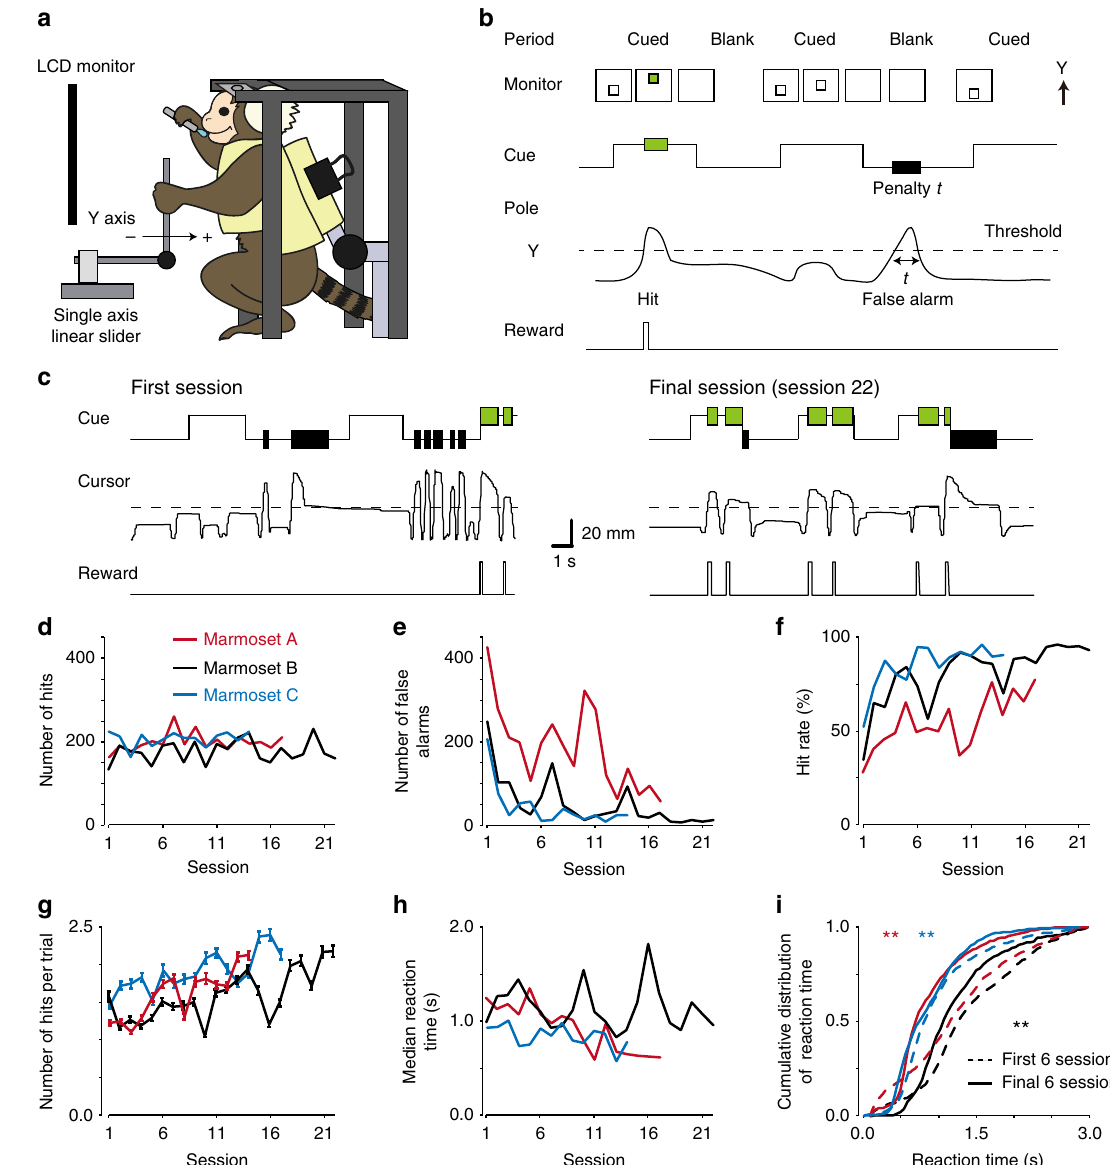
Fig. 2 Learning of visually cued pole-pull task. a Scheme of the task apparatus and head- fi xed marmoset. b Schematic diagram of the task. c Example of pole trajectories from marmoset B. d – g Time course of the hit number ( d ), the false alarm number ( e ), the hit rate ( f ), and the hit number per trial ( g ) across sessions. In g , only trials with at least one hit event were analyzed ( n = 73 – 183 trials for each session). Error bars indicate SEM. Spearman correlation coef fi cients (CCs) between the hit number and training session were 0.35, 0.09, and 0.07 (0.22, − 0.04, and 0.33 without the initial session) for marmosets A, B, and C, respectively, P >0.05 for all cases. CCs between the false alarm number and training session were − 0.72, − 0.79, and − 0.58 for marmosets A, B, and C, respectively, P <0.01 for marmosets A and B, P <0.05 for marmoset C. Without the initial session, CCs were – 0.66, – 0.76, and – 0.47 for marmosets A, B, and C, respectively, P <0.01 for marmosets A and B, P = 0.10 for marmoset C. CCs between the hit rate and training session were 0.72, 0.84, and 0.67 (0.66, 0.82, and 0.59 without the initial session) for marmosets A, B, and C, respectively, P <0.01 for marmosets A and B, P <0.05 for marmoset C. CCs between the hit number per trial and training session were 0.81, 0.71, and 0.81 (0.77, 0.77, and 0.77 without the initial session) for marmosets A, B, and C, respectively; P < 0.01. h Median reaction time. i The cumulative distribution of reaction time. For marmoset A: 1203±29ms in the fi rst six sessions vs. 833±21ms in the fi nal six sessions, n = 664 and 578 trials, respectively, ** P <0.01, Wilcoxon rank-sum test. For marmoset B: 1396±26ms vs. 1207±25ms, n = 763 and 569 trials, respectively, ** P <0.01. For marmoset C: 1032±18ms vs. 904±17ms, n = 952 and 673 trials, respectively, ** P activities relevant to the upper-limb movements can be detected We therefore used a soft jacket 27 to restrain the trunk of the by two-photon imaging over periods of minutes and days. animal (Fig. 1a). In this study, we trained four adult marmosets, step by step, to perform upper-limb movement tasks with head fi xation (Supplementary Fig. 1). First, we habituated the mar- Results mosets to an experimental apparatus with jacket restraint for Training of upper-limb movement tasks without head fi xation . 10 – 60 min (one session) per day. Food and water were restrained Physical constraint of the neck and waist may make it dif fi cult for during the habituation and training days. In the initial training head- fi xed marmosets to learn an upper-limb movement task 26 .